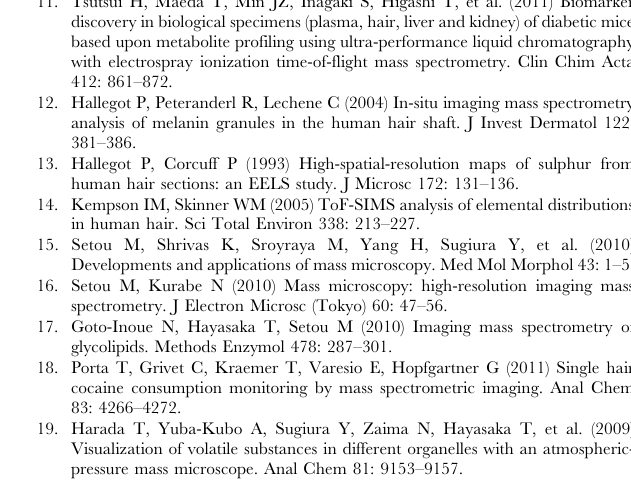
sections from the subjects of 20-YO group are presented. *: The section in which medulla was defined. Scale bar: 100 m m. (TIF) Figure S2 Light microscopic images of hair sections of 50-YO group. High resolution microscopic images of the hair sections from the subjects of 50-YO group are presented. *: The section in which medulla was defined. Scale bar: 100 m m. (TIF) Figure S3 Extraction of hair-specific molecules. (A) The m/z values with the top 50 intensities in the hair-specific ROI of each subject are listed. The number over the image indicates the subject No. Solid lines in a visual image indicate ROI. Scale bar: 100 m m. Bold letter: A value selected in more than 1 subject. (B) M/z values selected in more than 1 subject in (A) are listed. Red letter: Finally selected hair-specific molecule. (TIF) Figure S4 MS/MS analysis. (A–D) Mass spectra of secondary ions by fragmentation of the precursor ion at m/z 207.04 are presented. Measurement of precursor ions at energy level of 0. (B) Fragmentation at energy level of 10. (C) Fragmentation at energy level of 30. (D) Fragmentation at energy level of 50. The inserted pictures present the area on the hair sections on which the lasor was pulsed for ionization. (E) Light microscopic images of the hair sections are shown. Lasor-pulsed areas are framed. Scale bar: 50 m m.